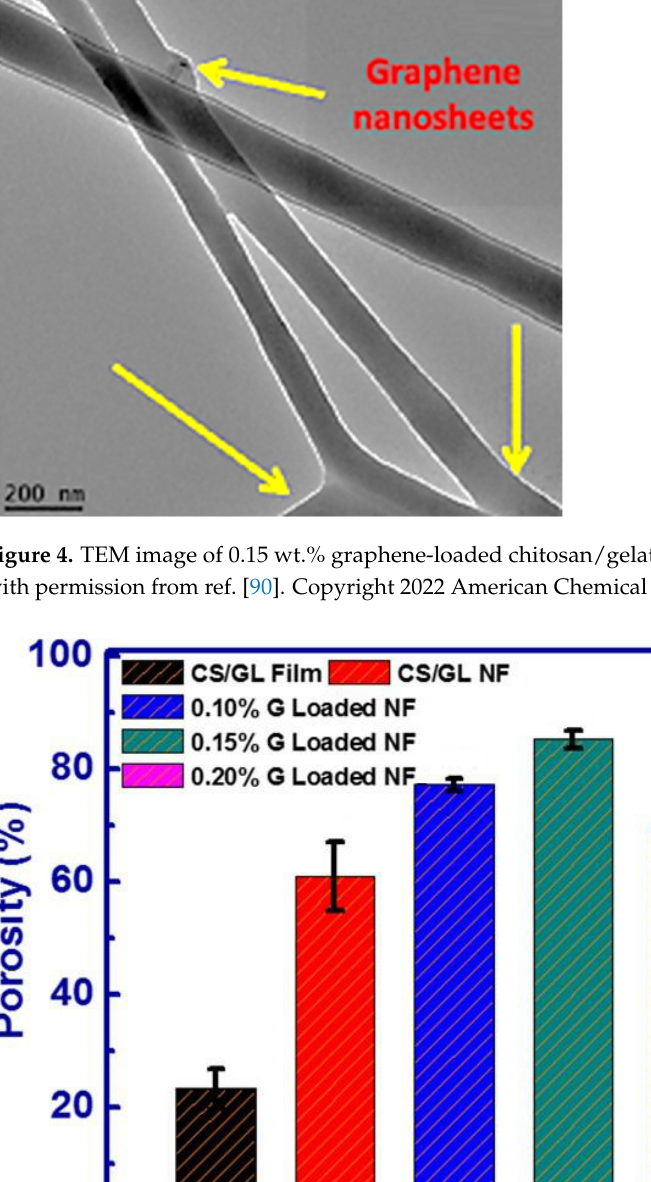
Figure 5. Porosity % of the fabricated nanofiber scaffolds [90]. GS/GL NF—chitosan/gelatin nano fiber. Reproduced with permission from Reference [90]. Copyright 2022 American Chemical Soci- ety.